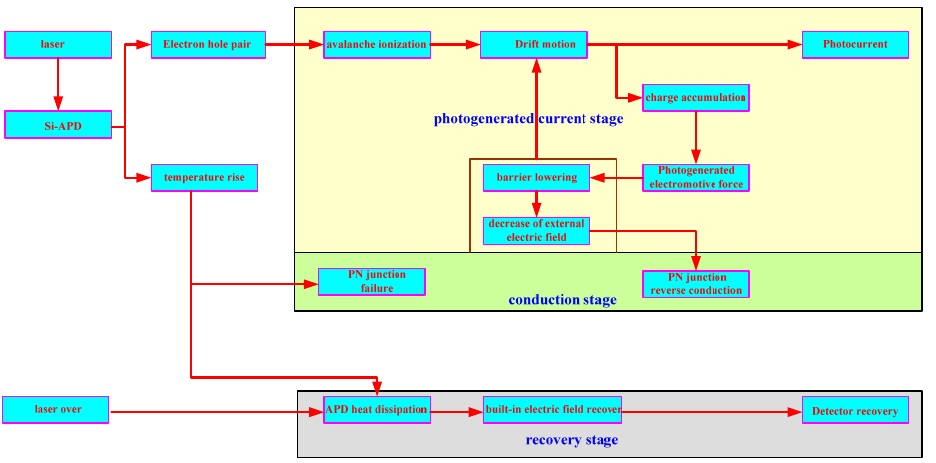
Figure 5. The internal mechanism of generating a photocurrent when the millisecond pulse laser irradiates APD.